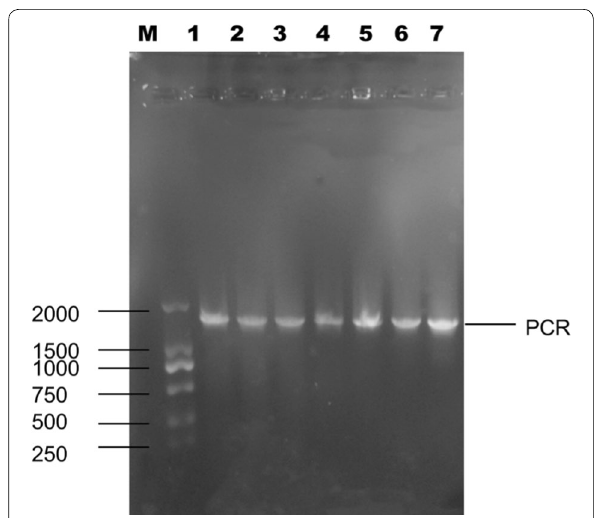
Fig. 2 Electrophoresis of PCR-amplified 16 S rDNA gene fragments from 7 strains (left to right: Marker, 05, 08, 13, 23, 27, 10,